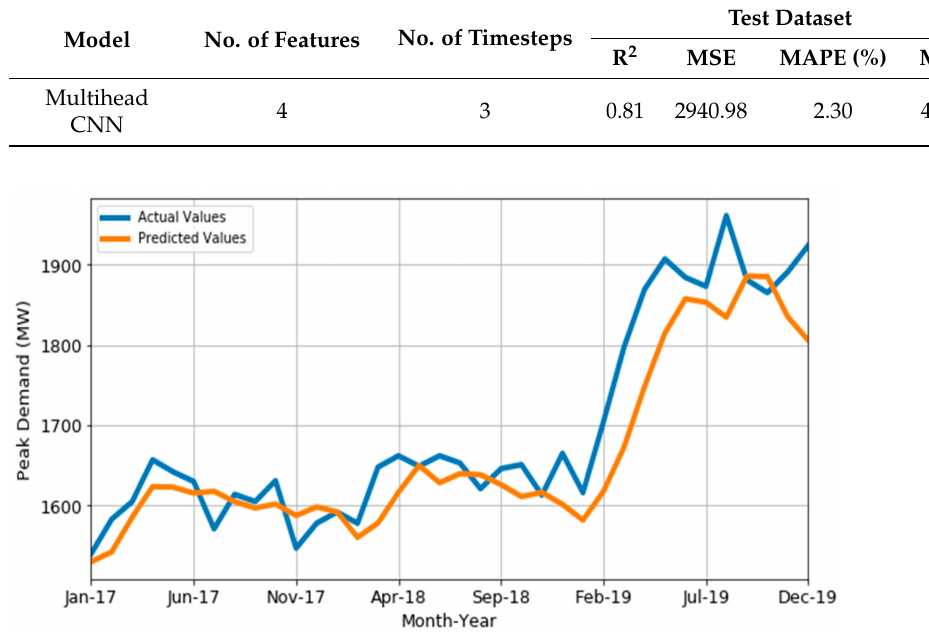
Figure 14. Performance of the multihead CNN model on the test set.